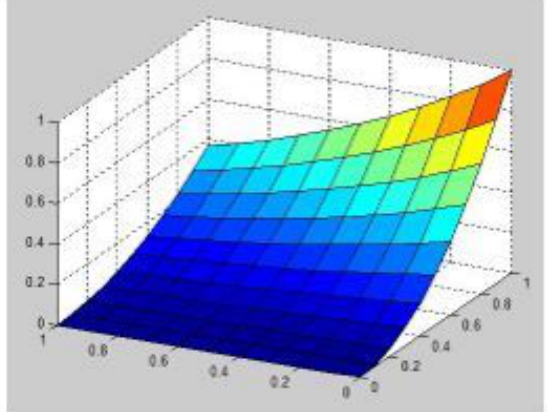
Figure 3: Approximate solution of Eq. (11) using AHPSTM (11), (19) and (28) we employe a statistical technique i.e. paired student’s t-test at 5% level of significance to the data of Tables 2, 4 and 6. The null hypothesis is